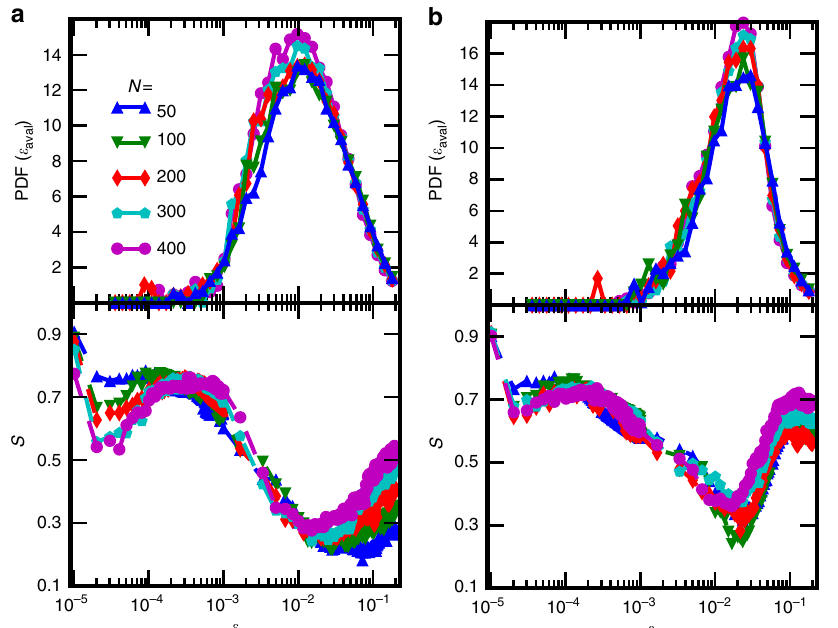
Fig. 4 Stochastic strain bursts lead to deterioration of deformation predictability. Top: Probability density of the starting strain of the avalanches, ε aval , in a basic and b ID systems. Bottom: The same ANN score S as in Fig. 2 (with a showing data for the basic and b for the ID systems) with a logarithmic strain axis, revealing also an additional local minimum of S ( ε ) for small